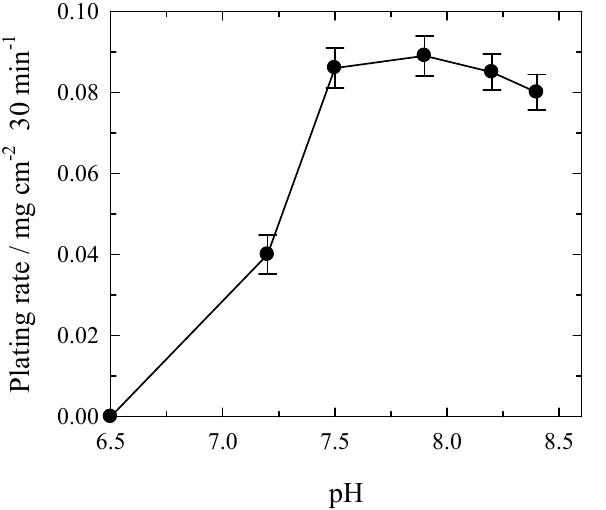
Figure 2. Dependence of plating rate of Pt on the solution pH under conditions with Ar bubbling. Solution contained (mol L − 1 ): H 2 PtCl 6 —0.004; NH 4 OH—0.4; complexing agent—0.16; CoCl 2 —0.2; HCl to pH = 7.5; t dep = 30 min; 20 ° C.